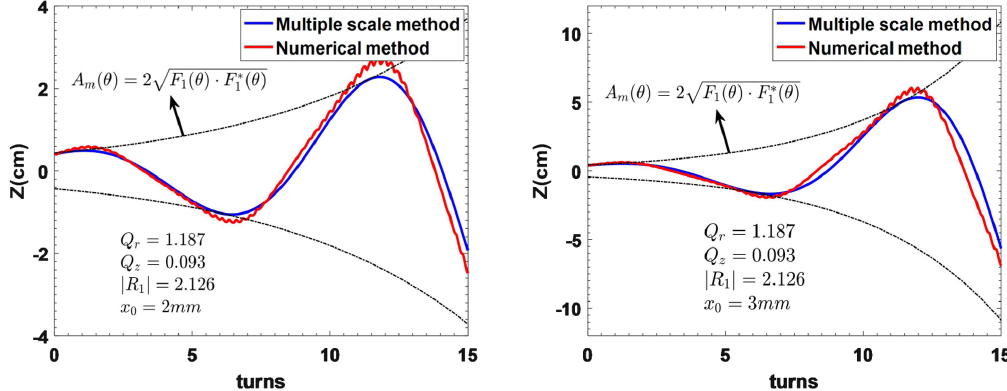
− 2 Q ¼ 1 with the same r z